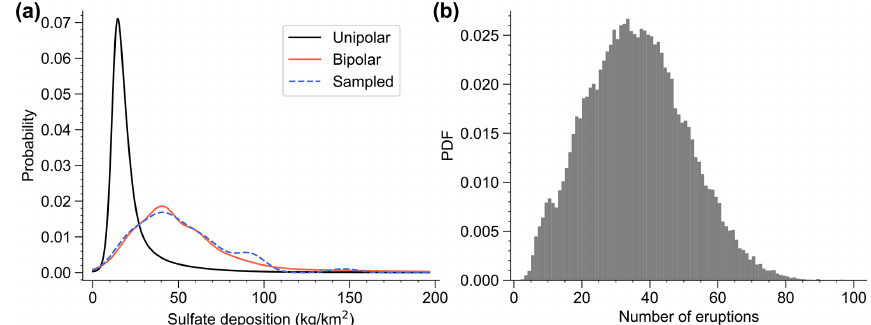
Figure 4. (a) Kernel density estimate of the Antarctic sulfate deposition in the unipolar and bipolar LIN22 data sets, as well of a large number of samples from the resampling method described in Appendix B (dashed blue line), wherein subsamples from the unipolar data set are drawn such that they follow the distribution of the bipolar population. (b) Histogram of the number of eruptions contained in each unipolar subsample after 50000 iterations of the resampling